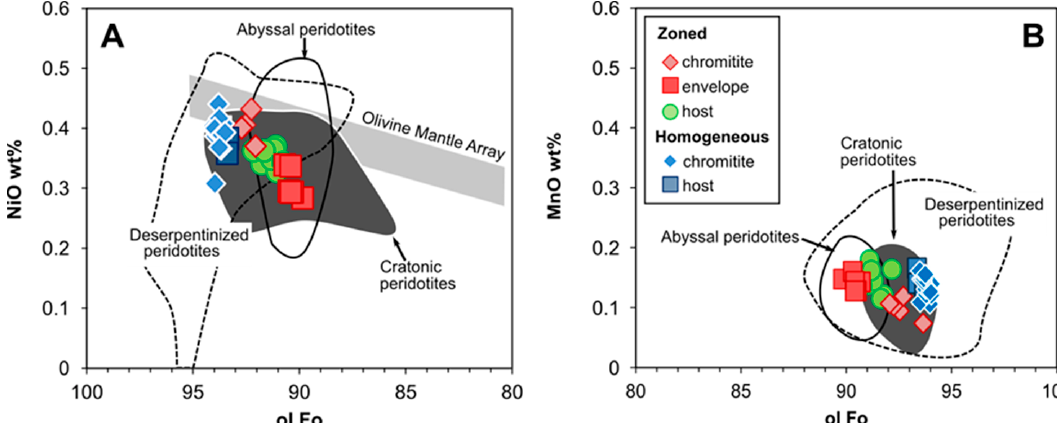
Figure 5. ( A ) Olivine forsterite content vs. NiO wt % plot of the Ulamertoq samples. Compositional fields of other metamorphic olivine and residual mantle olivine from typical abyssal peridotites and cratonic spinel-facies peridotites [29–32] are also plotted. The mantle olivine array is from Takahashi et al. [33]; ( B ) The olivine forsterite content and MnO wt % of the Ulamertoq samples are compared with other metamorphic olivine from various studies and olivine from typical residual abyssal peridotite from Warren [34]. Compositions of metamorphic olivine from the Happo-O’ne peridotite complex [35], Tari-Misaka [36], Ohsa-Yama [37] in Japan, and abyssal peridotites [34] are also included for comparison.